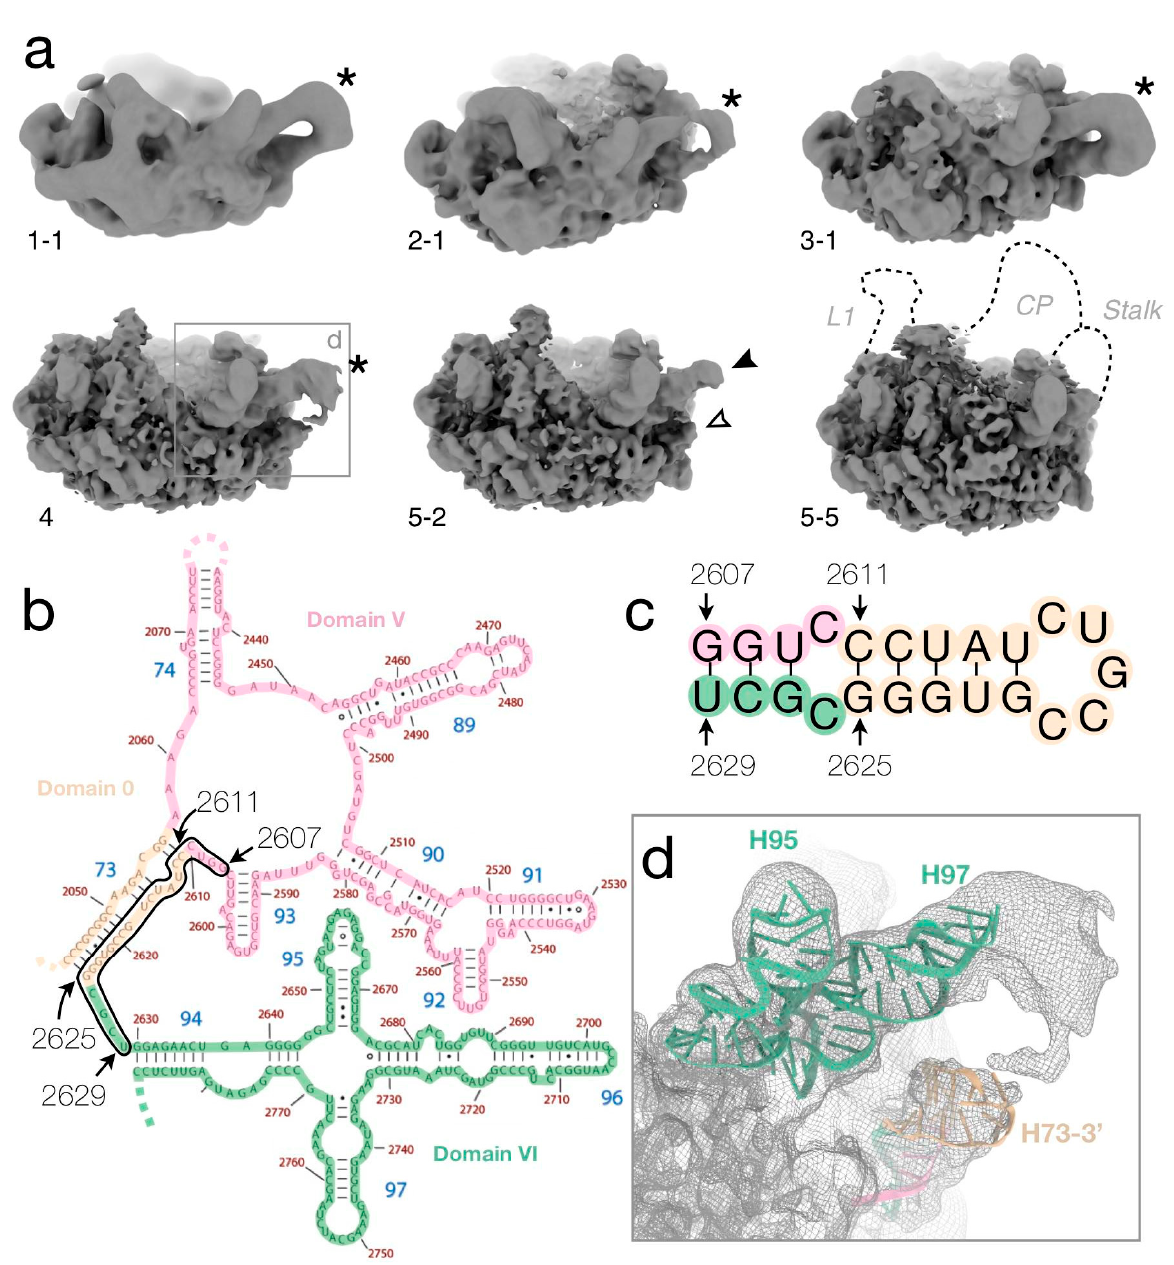
Figure 5. Non-native density close to the base of the L7/L12 stalk. ( a ) In classes 1-1, 2-1, 3-1, and 4, the density of H97 extends and loops back (asterisk) at lower map thresholds. In class 5-2, the density for the upper (black arrowhead) and lower (white arrowhead) arms are not